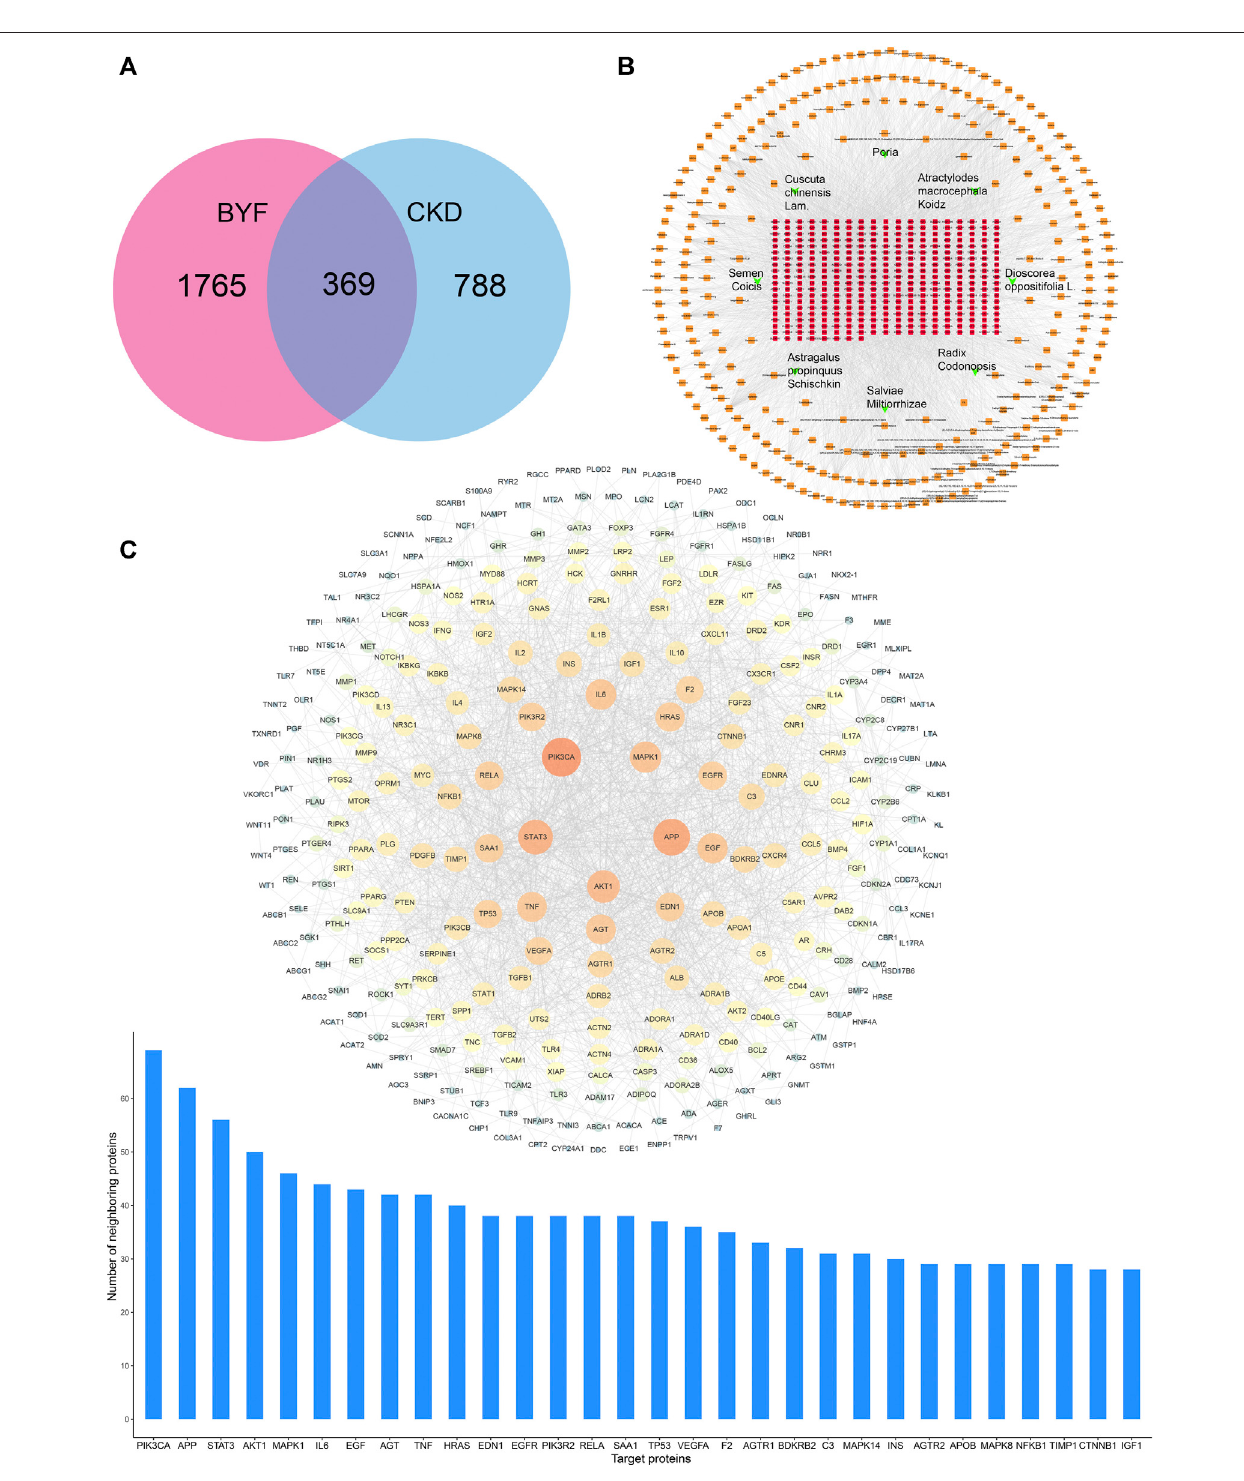
FIGURE 1 | BYF network pharmacology analysis against CKD. (A) Venn diagram revealing BYF and CKD common target genes; (B) Drug-compound – target interaction network diagram; (C) PPI network and the proteins with the top 30 ° among common BYF and CKD targets.